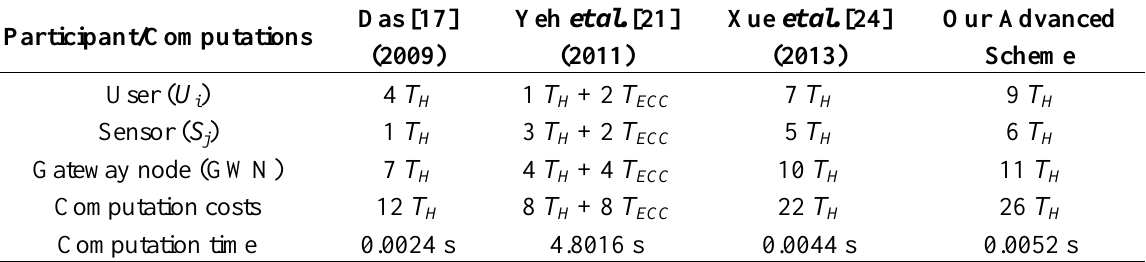
Table 5. Performance comparisons of our advanced scheme and related